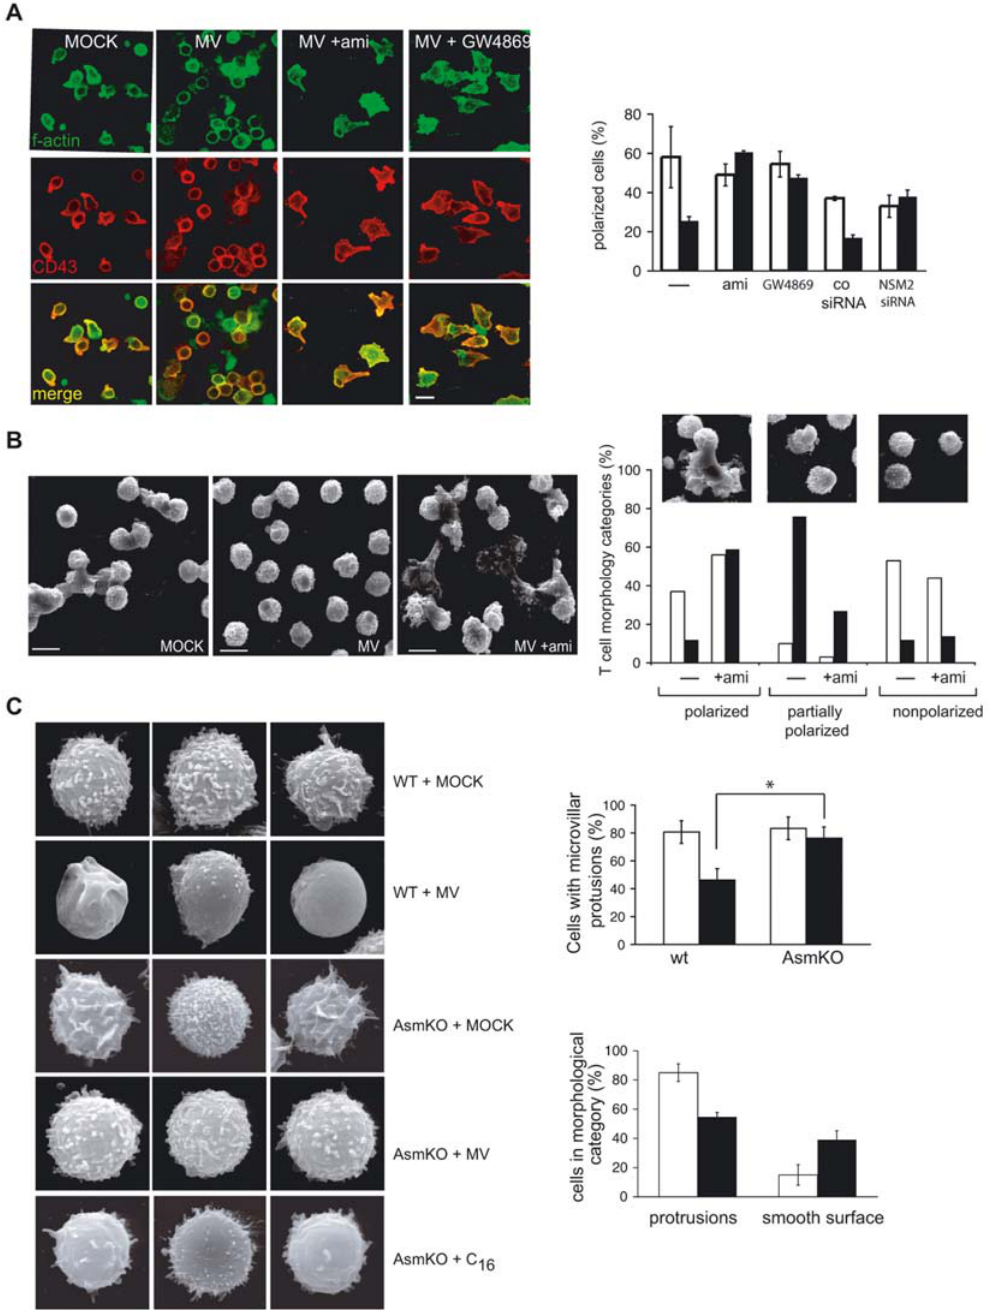
Figure 3. SMase activation accounts for MV-induced prevention of T cell polarisation and loss of membrane protrusions. (A) Human T cells were transfected with a NSM2-specific or a scrambled siRNA for 96 hrs or exposed to amitriptyline (ami) or GW4869 2 hrs prior to MOCK (right panel, white bars) or MV (right panel, black bars) exposure for 2 hrs at 4 u C and subsequently seeded onto FN-coated slides. Cells were fixed after 30 min and stained for f-actin and CD43 (exemplified in the left panel, with the scale bar representing 5 m m) and the percentage of cells revealing a front-rear polarisation with CD43 enriched in the uropod was determined. At least 100 cells per culture were recruited into the analysis. (B) Human T cell cultures exposed to MOCK or MV (pre-exposed to amitriptyline for 24 hrs or not) were seeded onto FN coated slides and analysed by SEM (left panel; bars represent 5 m m). Right panel: Cells in each culture were scored into morphological categories (non-, partially or fully polarized; see insets for examples; 100 cells per culture were counted) and the respective percentage of cells exposed to MV (black bars) or MOCK (white bars) was determined. (C) Left panel: Spleen cells from wild-type (upper and second row) or AsmKO mice (middle to bottom row) were exposed to MOCK (upper and third row), MV (second and fourth row) or C 16 ceramide (bottom row) prior to seeding onto FN and subsequent SEM analysis. Right, upper panel: Wild-type or AsmKO spleen cells exposed to MV (black bars) or MOCK (white bars) were seeded onto FN and the percentages of cells forming membrane protrusions in each culture were determined by SEM. Right, bottom panel: AsmKO cells exposed to MOCK (white bars) or C 16 ceramide (black bars) were seeded onto FN and percentages of cells revealing membrane protrusions or with smoot appearance were determined. Both right panels: At least 100 cells were recruited into the analysis per culture. Levels of significance were determined using a t-test (p=0.01).